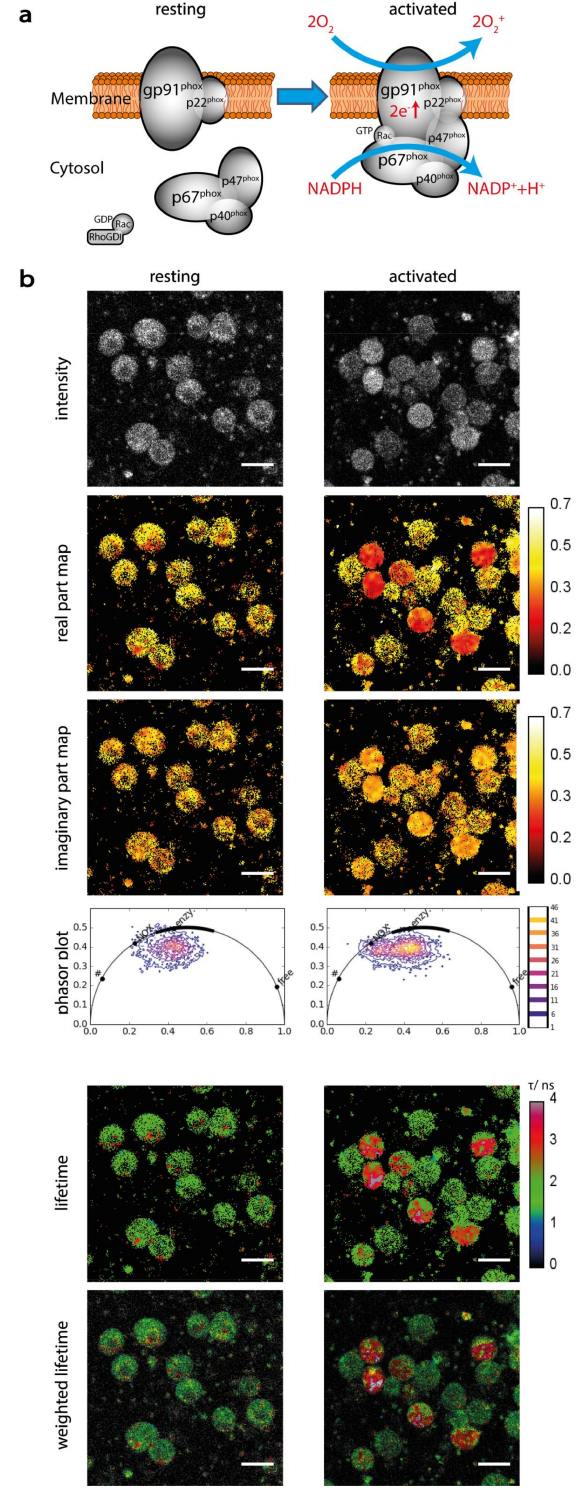
Figure 2. Selective detection of NAD(P)H-dependent enzymatic activity ( a ) Resting and active NADPH oxidase 2 (NOX2). The subunits gp91 phox and p22 phox form the membrane-associated component of the enzyme, whereas p67phox, p47phox and p40phox the cytosolic cyclic hetero-trimer. If stimuli, e.g., pathogens, are present, the cytosolic part translocates to the membrane-associated part under phosphorylation of p67 and the activable enzyme assembles. The assembled NOX2 is now able to